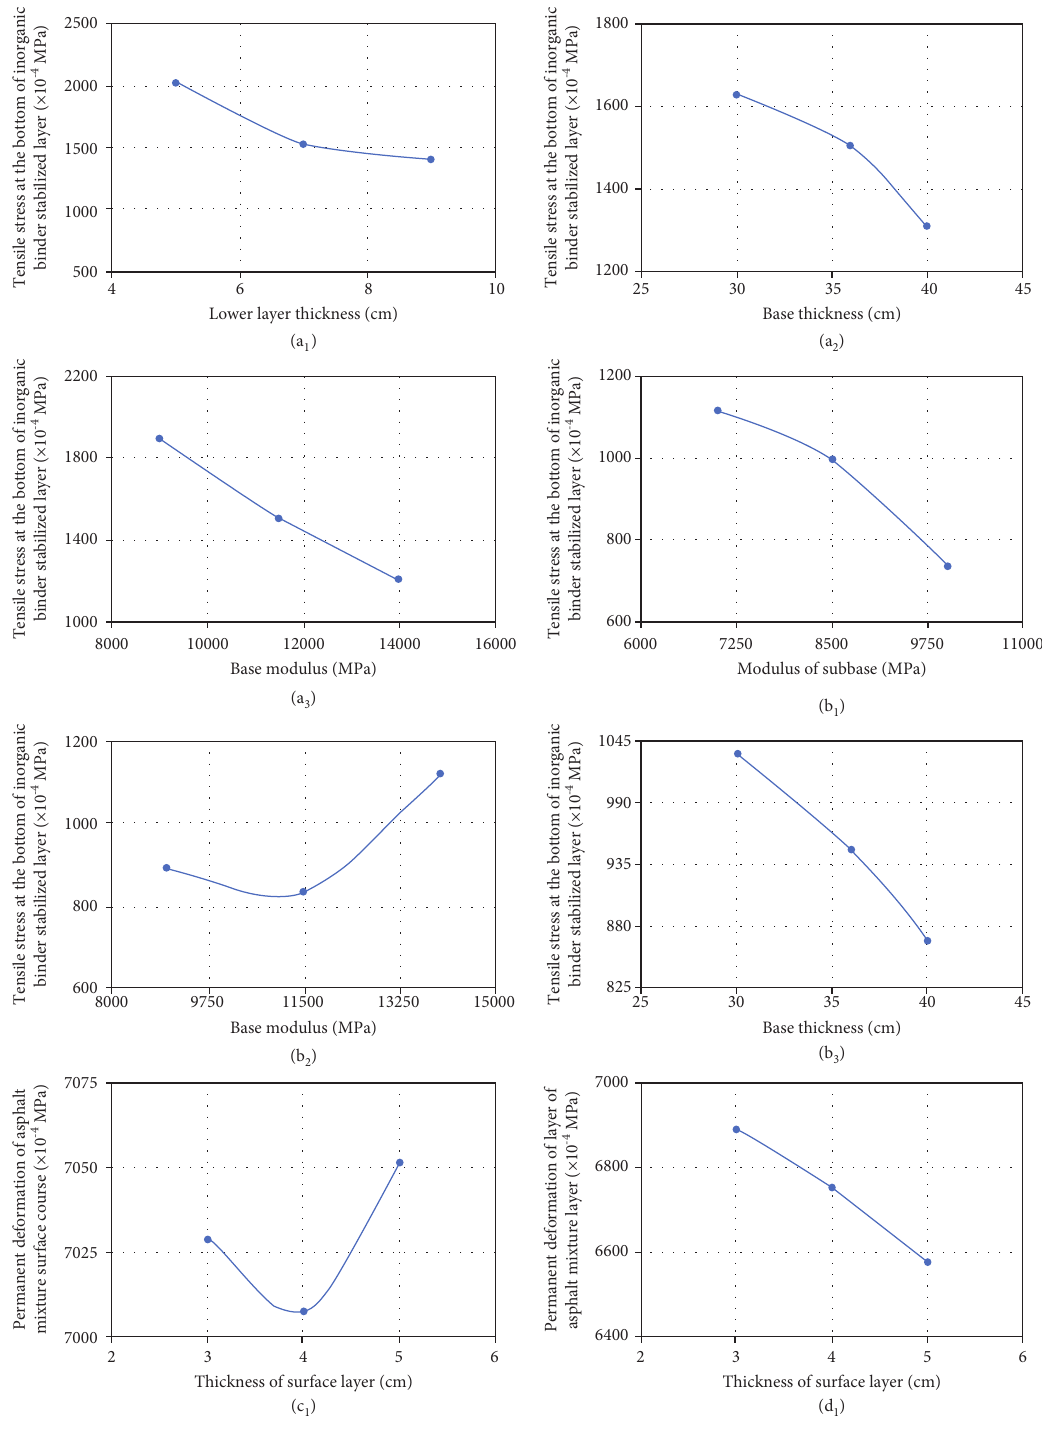
Figure 3: Trend chart of working condition